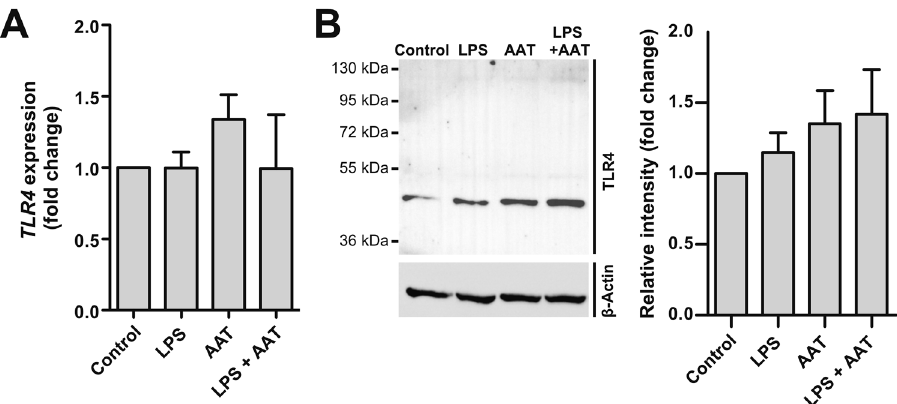
Figure 11. Effect of exogenously added LPS and AAT on TLR4 gene and TLR4 protein levels in H1975 cells. Cells were cultured for 18 h in the medium containing HBSS (controls), 10 µ g/ml LPS, 50 nM STS, or 1.5 mg/ ml AAT separately and in combinations. ( A ) TLR4 gene expression was related to housekeeping gene POLR2A . Results are shown as fold changes normalized to non-treated controls. Each bar represents mean (SD) of three independent experiments. ( B ) TLR4 protein levels were analyzed by Western blot. Fold changes were calculated for each band using the ratio relative to β -actin, as a loading control, and then normalized by the experimental control. Each bar represents mean (SD). Representative blot is shown out of six independent